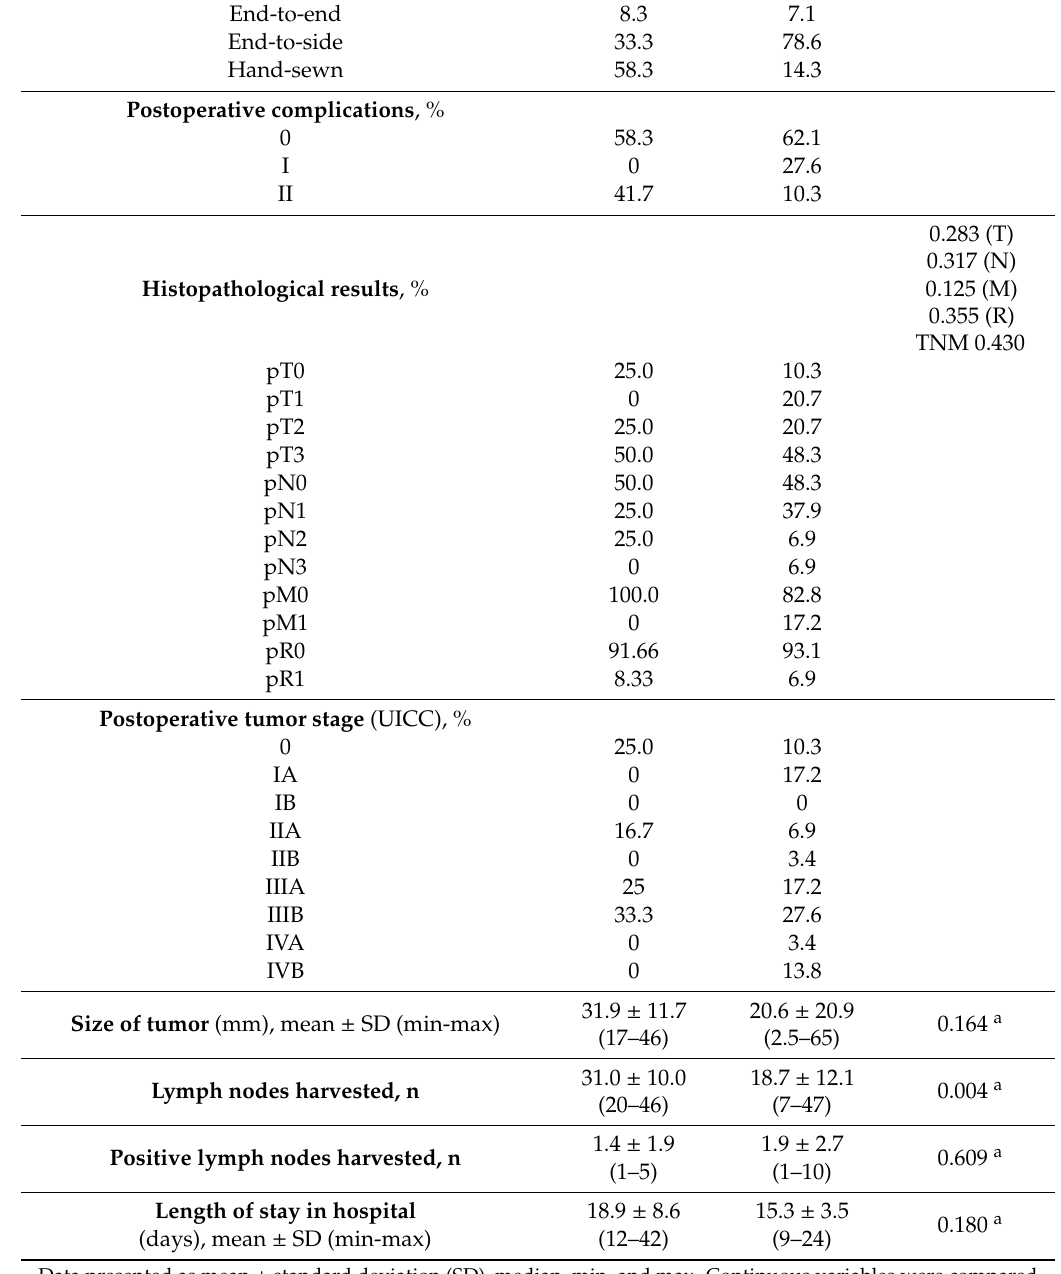
Table 2. Surgery-associated characteristics of all patients—cohorts stratified by surgical approach (RAMIE vs. OTE). Total time of surgery (min), mean ± SD